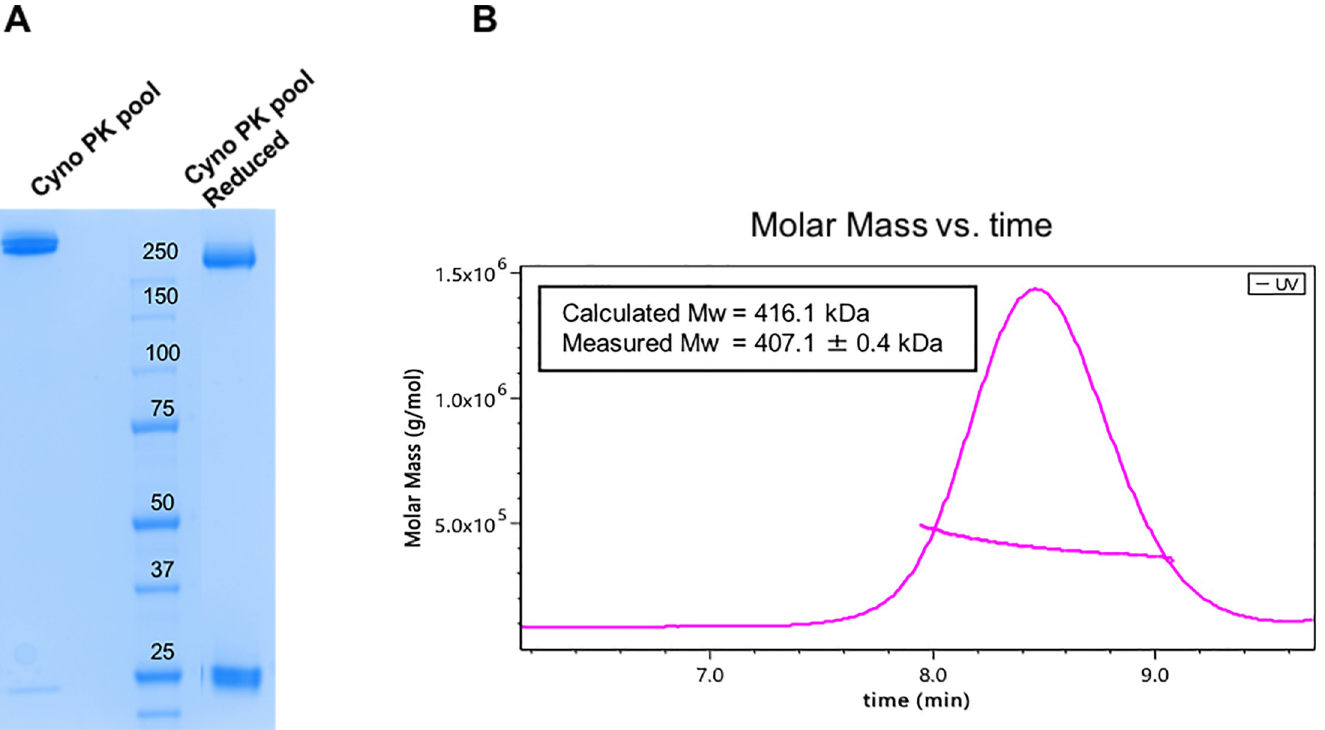
Fig 5. A. SDS-PAGE of final material, where the left lane is loaded with non-reduced Fab-PEG conjugate while the right lane contains the addition of DTT to reduce the interchain disulfide between HC and LC. Both lanes of the gel demonstrate a very tight band, with a high degree of purity, and little visible contaminants. B. SEC-QELS for 8X Fab + 8-arm PEG conjugate, with measured R H across UV trace demonstrates reproducibility independent of Fab identity.